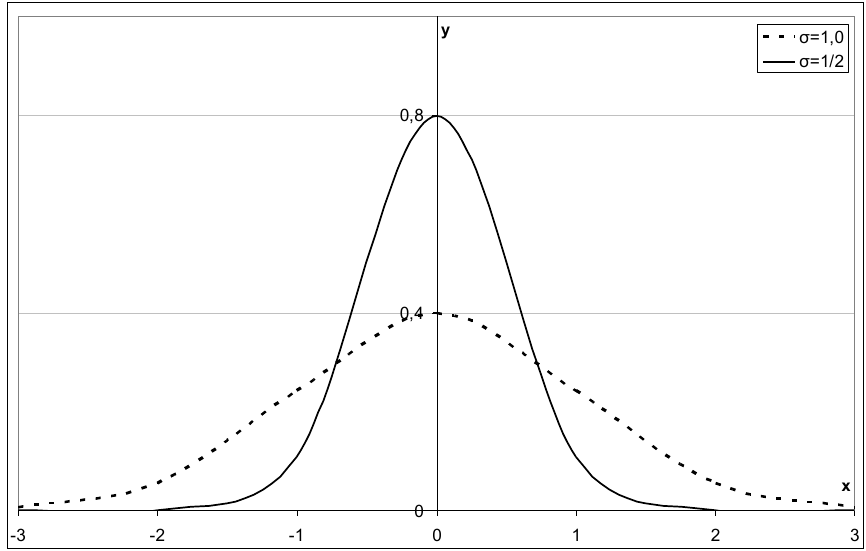
Figure 5. The Gaussian distribution density of a normalized random variable y = θ ( u ), where x = u = ( ω − ξ )/( ξ · σ ), with the center ξ and variance σ 2 .